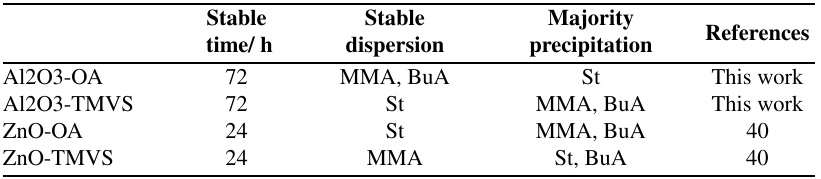
Table 5: Stable time and dispersion of modified